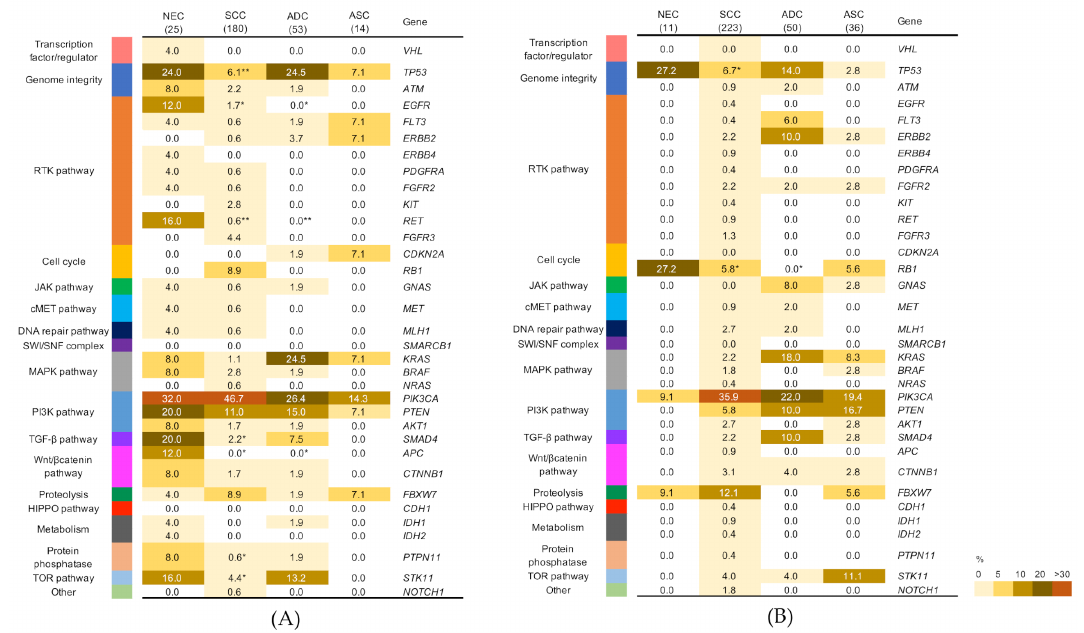
Figure 2. Association between genetic alterations and histological types in cervical cancer. Percentages of samples mutated in individual tumor types are shown. ( A ) the present study, ( B ) Project GENIE v8.0. The p -value was calculated using the Fisher’s exact test, * p < 0.05, ** p < 0.001. NEC: neuroendocrine carcinoma; SCC: squamous cell carcinoma; ADC: adenocarcinoma; ASC: adenosquamous